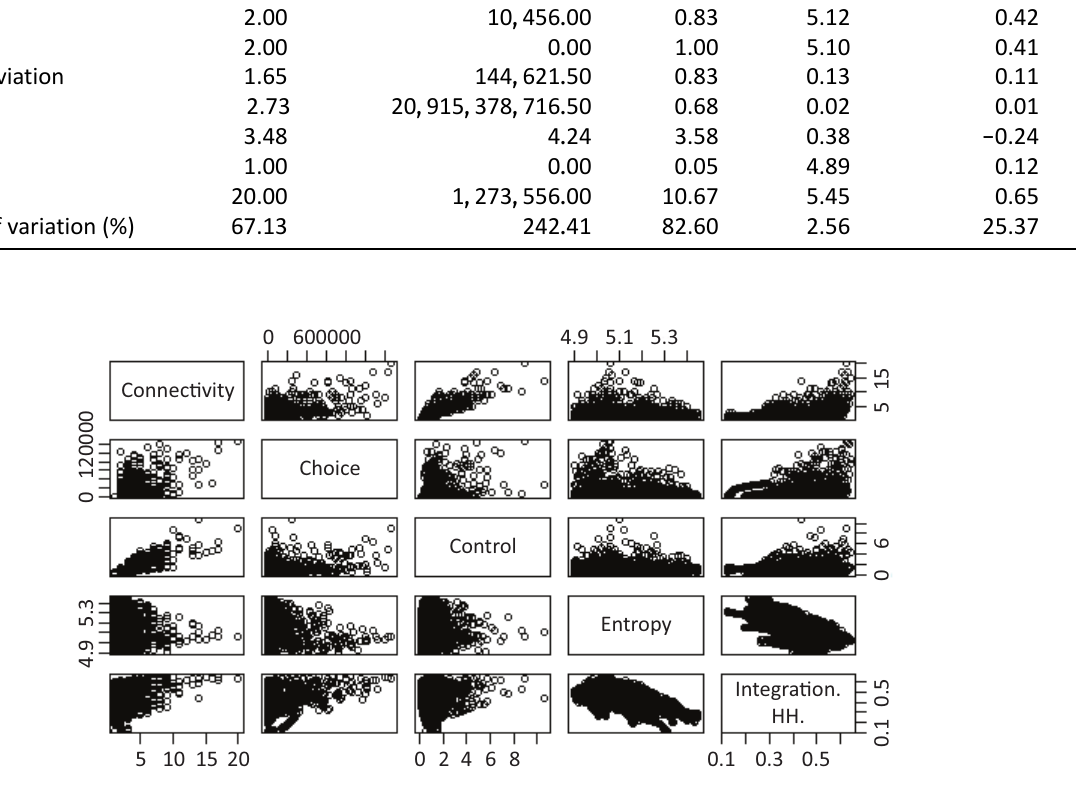
Figure 6. Plot descriptive statistic of urban space